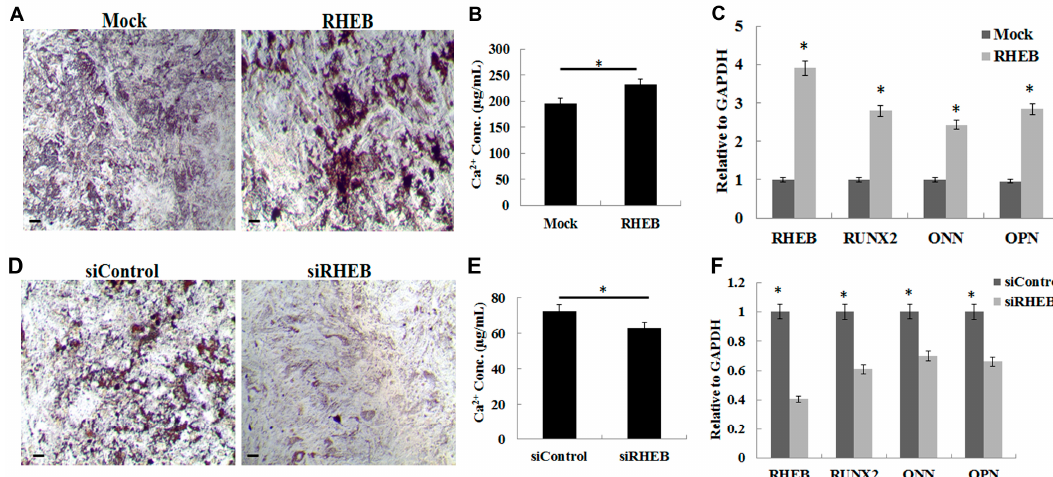
Figure 3. Effect of RHEB overexpression and knockdown on osteogenic differentiation of ASCs in differentiation media. ( A ) von Kossa staining showed higher phosphate and calcium mineralization in RHEB -overexpressed ASCs; ( B ) estimation of calcium concentration in the cells after RHEB overexpression; ( C ) the mRNA expression analysis by quantitative real-time PCR after RHEB overexpression; ( D ) von Kossa staining after RHEB knockdown in ASCs; ( E ) estimation of calcium concentration in the cells after RHEB knockdown; ( F ) the mRNA expression analysis by quantitative real-time PCR after RHEB knockdown. (Data are shown for a representative experiment as averages of triplicates with standard deviation. The statistical significance of differences was calculated using the Student’s t -test. * p < 0.05; Scale bar: 100 μ m).